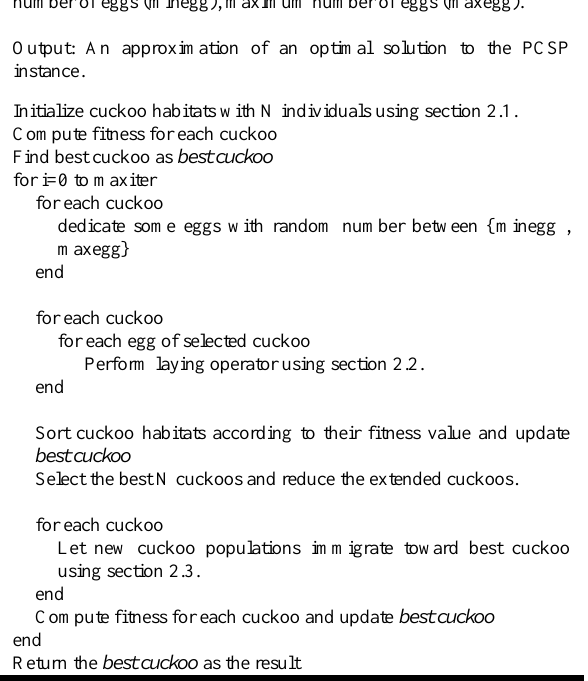
Figure 8. A migrant cuckoo habitat.